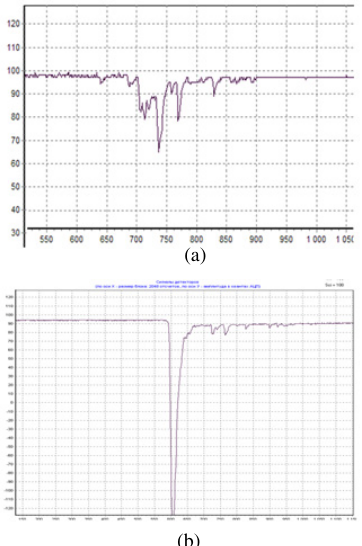
Figure 4. (a) Vertical air shower pulse. E 0 = 1 . 7 · 10 19 eV, θ = 18 ◦ , R = 1298 m. Detector with area s = 2m 2 and threshold ε ≥ 10MeV. (b) Inclined air shower event. E thr θ = 56 ◦ , ψ = 200 ◦ , R = 1000